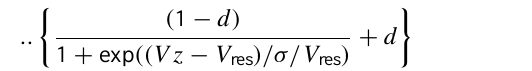
Fig. 5. Normalised linear equatorial growth rate plotted as a func- tion of frequency normalised to the equatorial electron gyrofre- quency, for Case 1. Linear growth rate is normalised to its value of 1200dB/s at the starting frequency of 0.35. The peak is due to the parallel velocity discontinuity at the initial resonance velocity at the